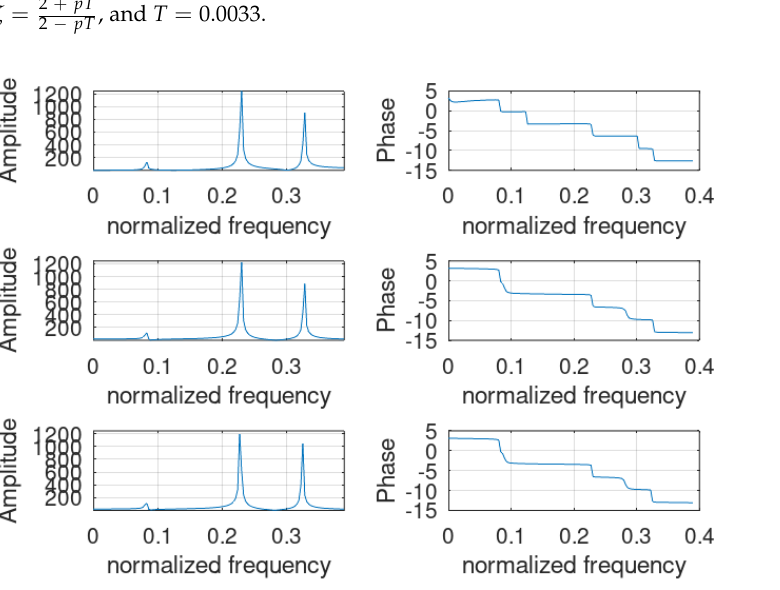
Figure 7. Comparison of original and transformed frequency responses with T = 0.0033 for an